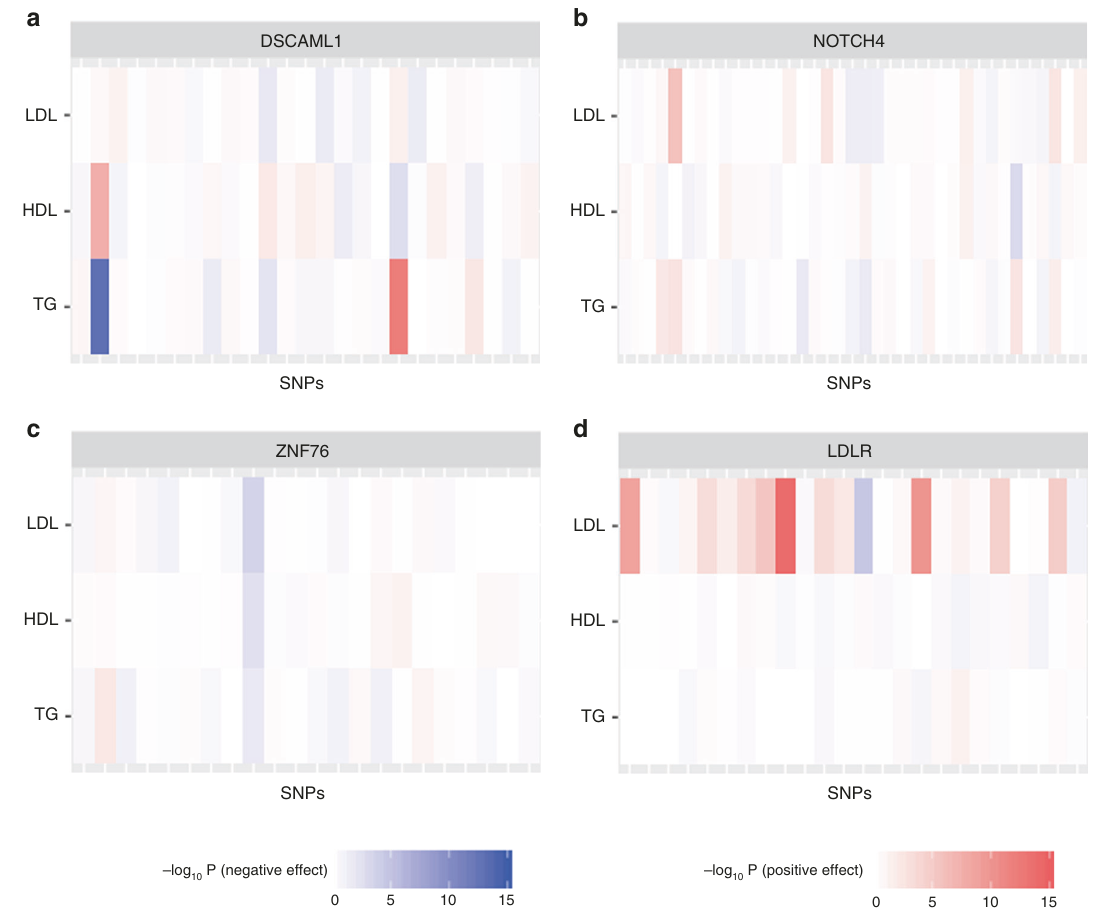
Fig. 4 Heat maps of association signals in the GLGC data for four example genes. The darkness of the color indicates the variant-level Z -test P -values (in − log Z -scores are indicated by red and blue colors, respectively. a The effect 10 scale) for individual traits LDL, HDL, and TG. The positive and negative correlations among traits resemble their genetic correlations. b The effects are independent among traits. c The effects are similar among traits. d Association signal resides in a single